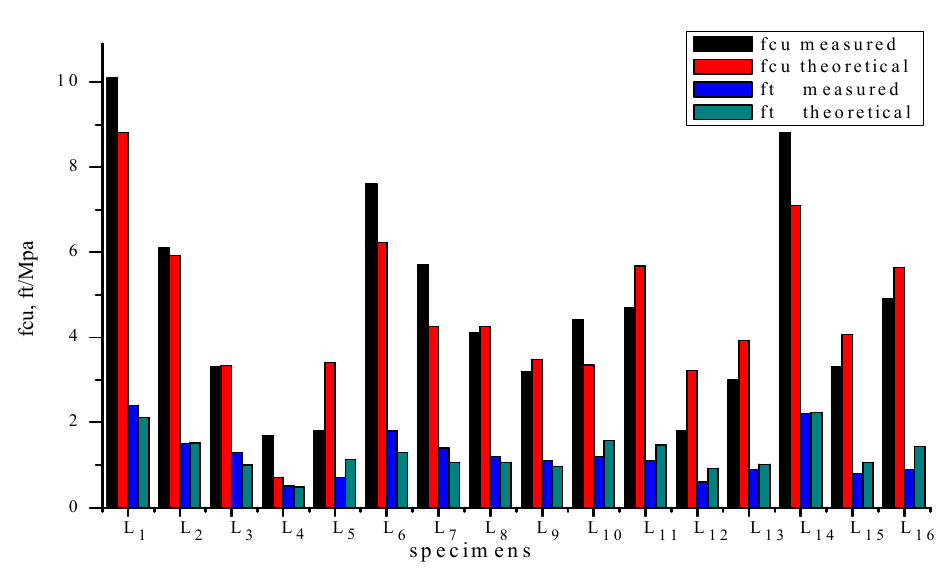
Figure 6. Intuitive analysis of the measured and theoretical strengths.